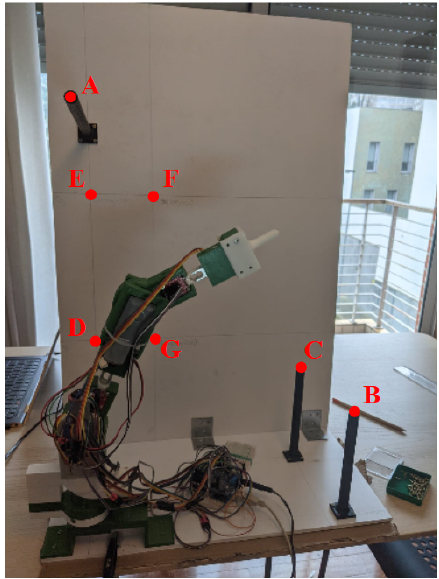
Figure 5. Structure used for accuracy tests with its interest points